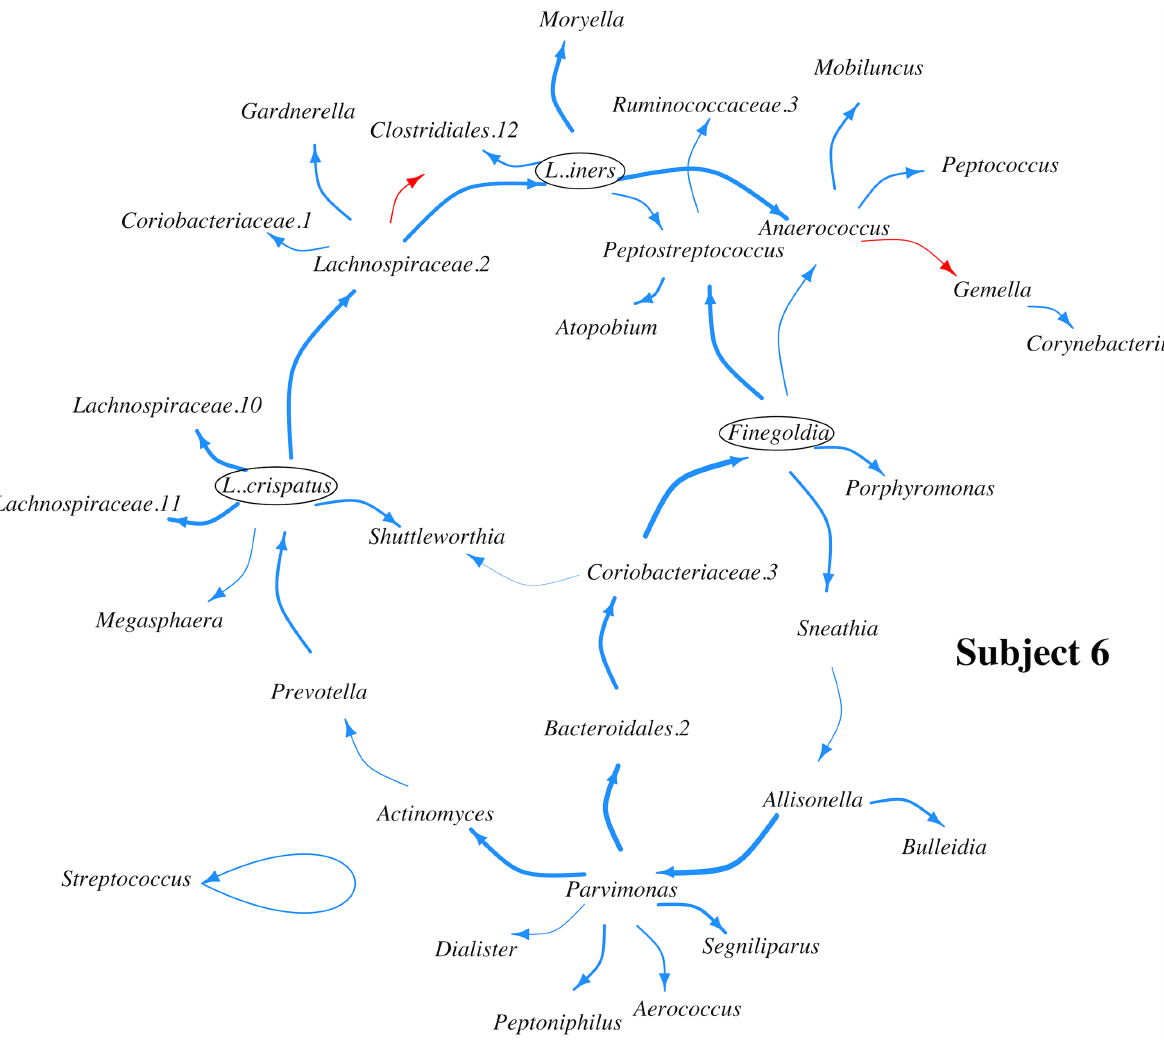
Fig 4. Microbial interaction network (MIN) for subject 6. Blue and red arrows indicatedirected positive and negativeeffects respectively. Arrow width indicateseffect magnitude. Circles highlightbacterial species that impact multipleother species in the MIN and whose critical role in the MIN has either experimental support in literature( L. iners ) or has never been recognized before ( Finegoldiasp. and L. crispatus